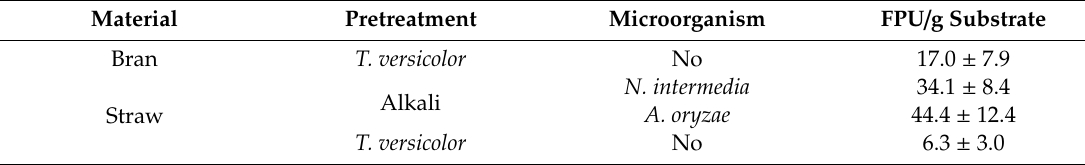
Table 4. Cellulase activity recovered by washing the fermented material before compression